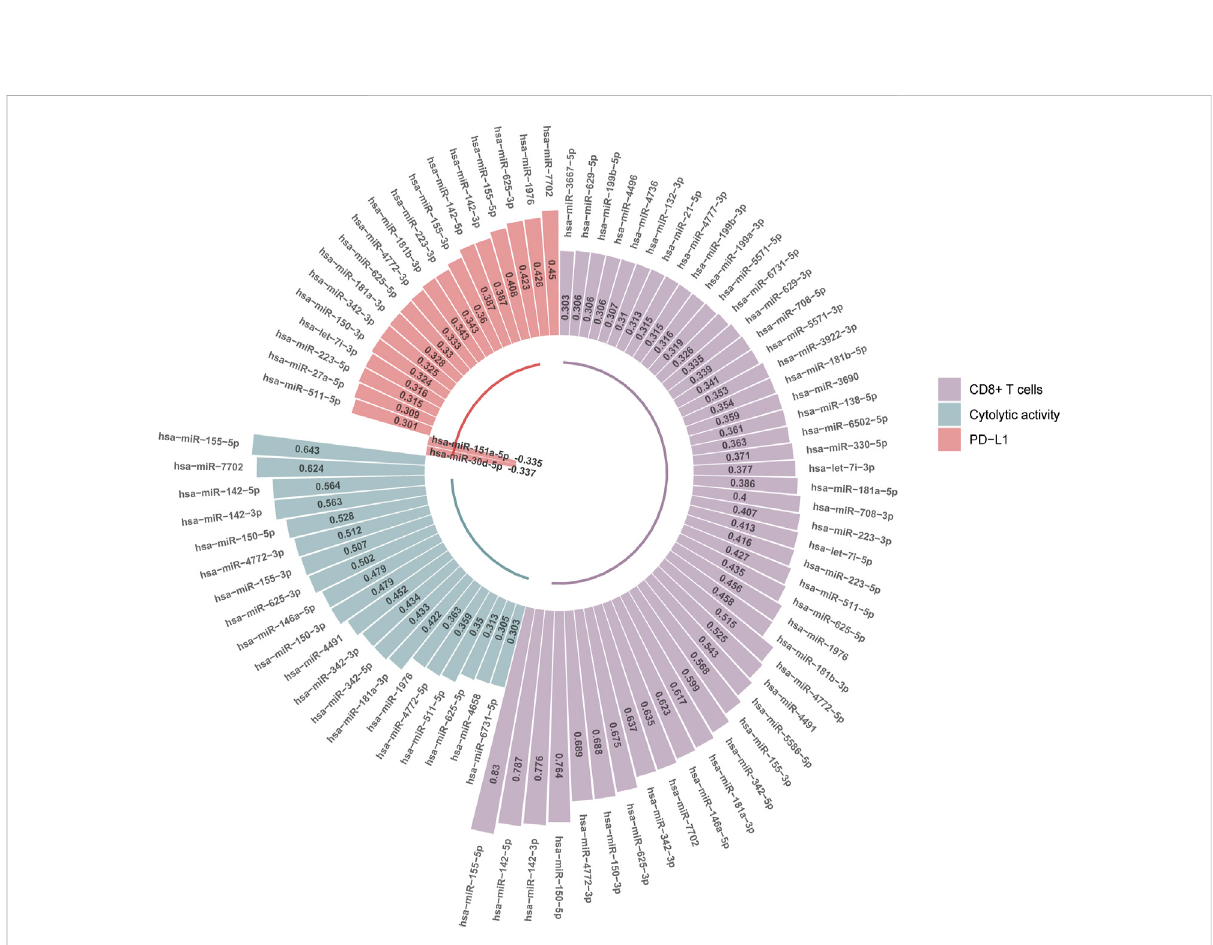
FIGURE 4 MicroRNAs(miRNAs)havingsigni fi cantexpressioncorrelationswithCD8 + Tcellenrichment,cytolyticactivity,or PD-L1 expressioninHCC(| r | > 0.3). The Pearson correlation coef fi cients ( r ) are shown.